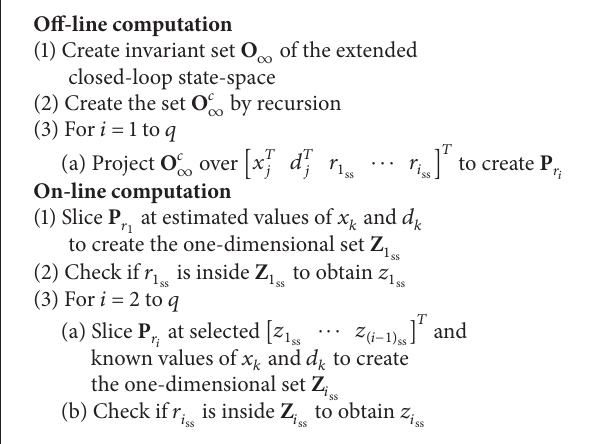
Algorithm 2: Sets of dynamically admissible